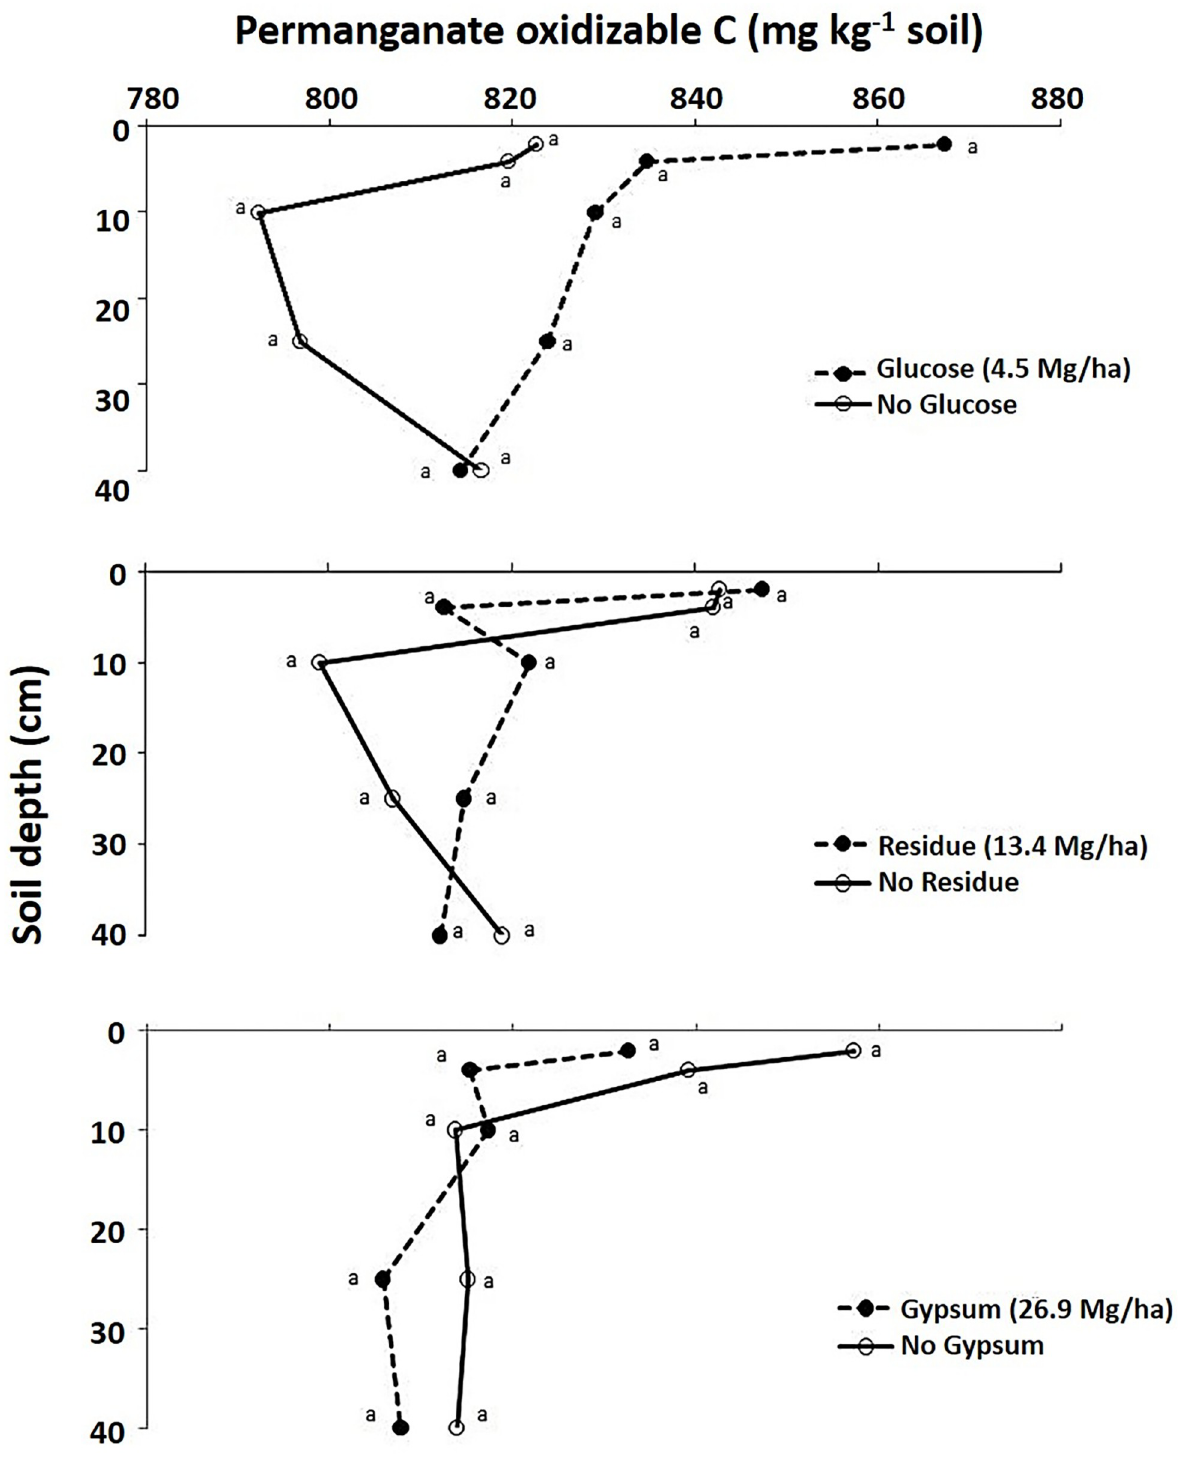
Fig 2. Effect of residue, glucose and gypsum on POXC in different soil layers averaged across the Wooster and Hoytville soils. Means with the same letter within the same layer are not statistically different (P < 0.10).